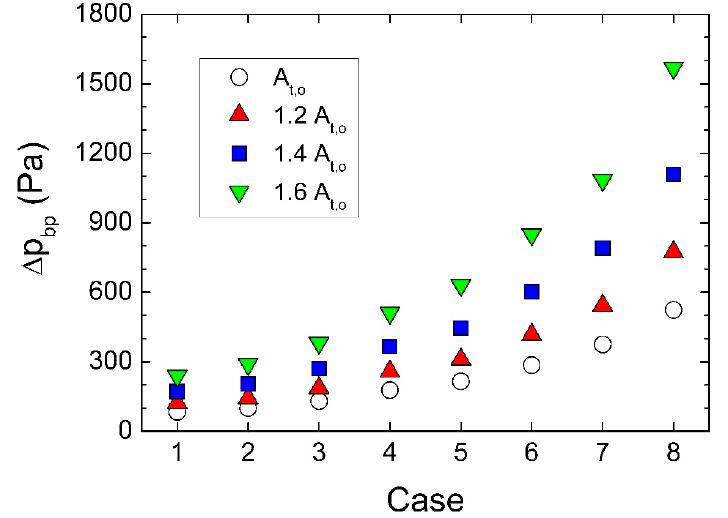
Figure 12. Back pressure Δ p bp of those cases analyzed in Figure 11. Numerical results.